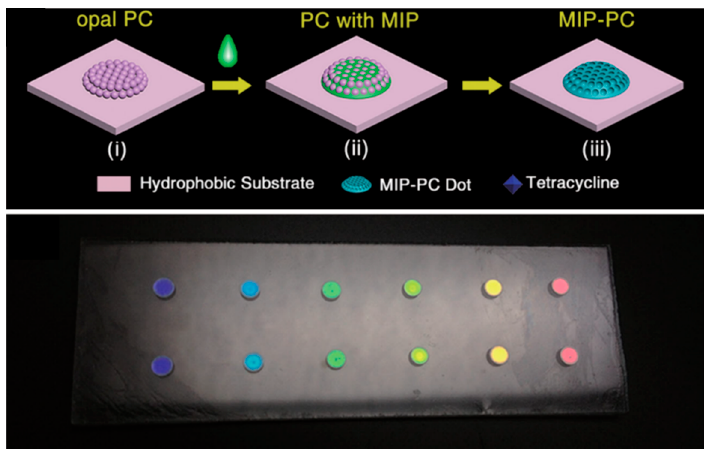
Figure 3. Upper panel: Fabrication process of the MIP–PC. MIP dots of diameter of 1.35 mm are polymerized on hydrophobic substrate. A 10 μ L volume of sample solution was dipped on the imprinted PC dot. In the presence of the analyte (tetracyclin), a visible change in color of the dot was visible after 10 min. Lower panel: Photographic image of the PC sensor with different colors of PC dots. Adapted from [112] with permission.